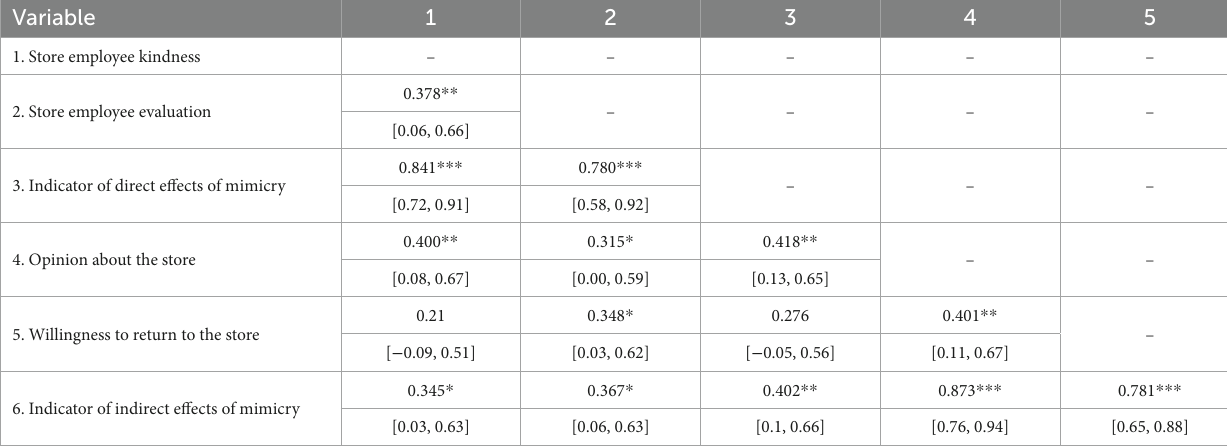
TABLE 2 Spearman’s rho correlation matrix between all individual factors with confidence intervals (Pretest).